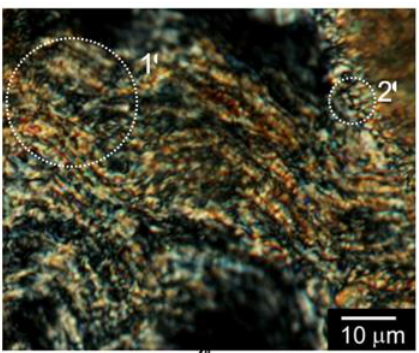
Figure 7. POM image of cast film of the SmC*–LC–poly(Ar–Pyr) blend with the chiral inducer prepared from THF solution. 1: Fingerprint-structure. 2: Diamond structure.